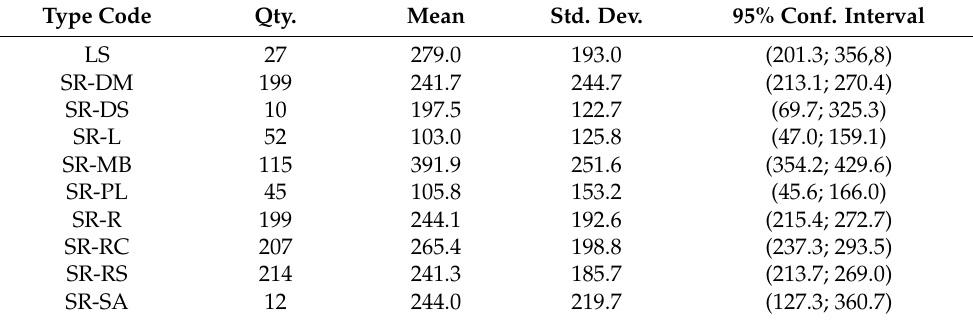
Table 7. ANOVA results for delay versus